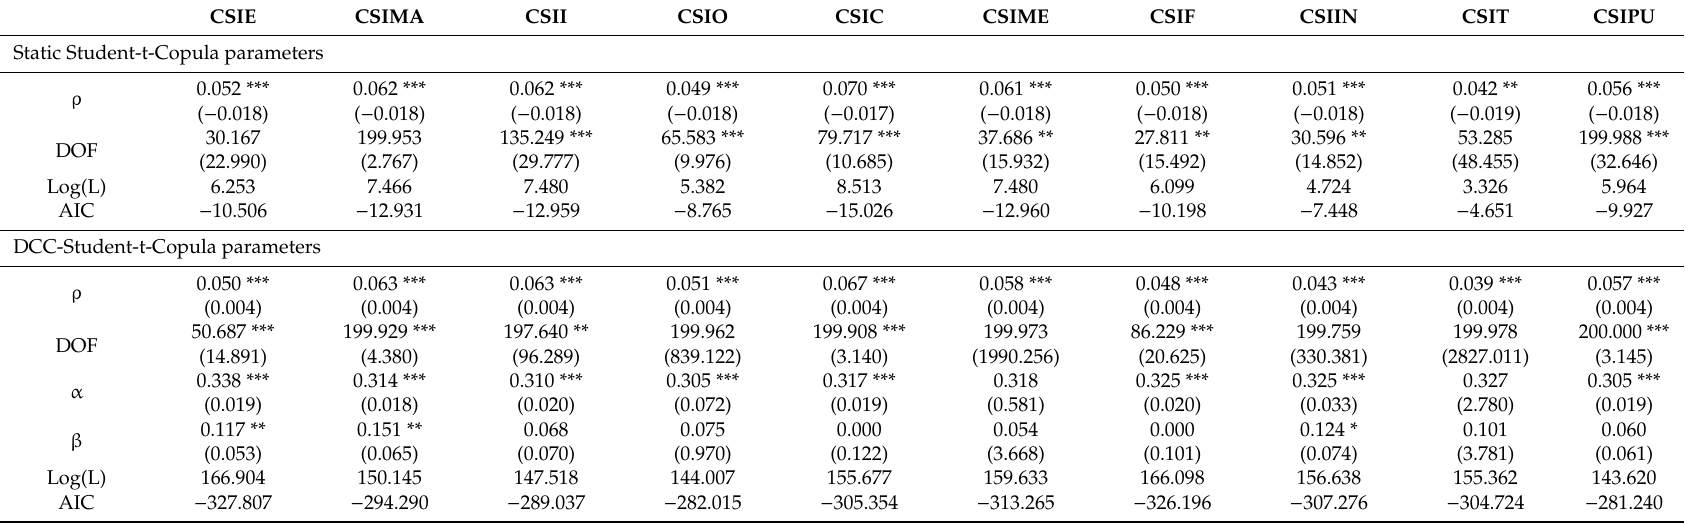
Table A2. Estimates of t-Copula for short-term trend between Brent spot price and the stock indexes of China Securities